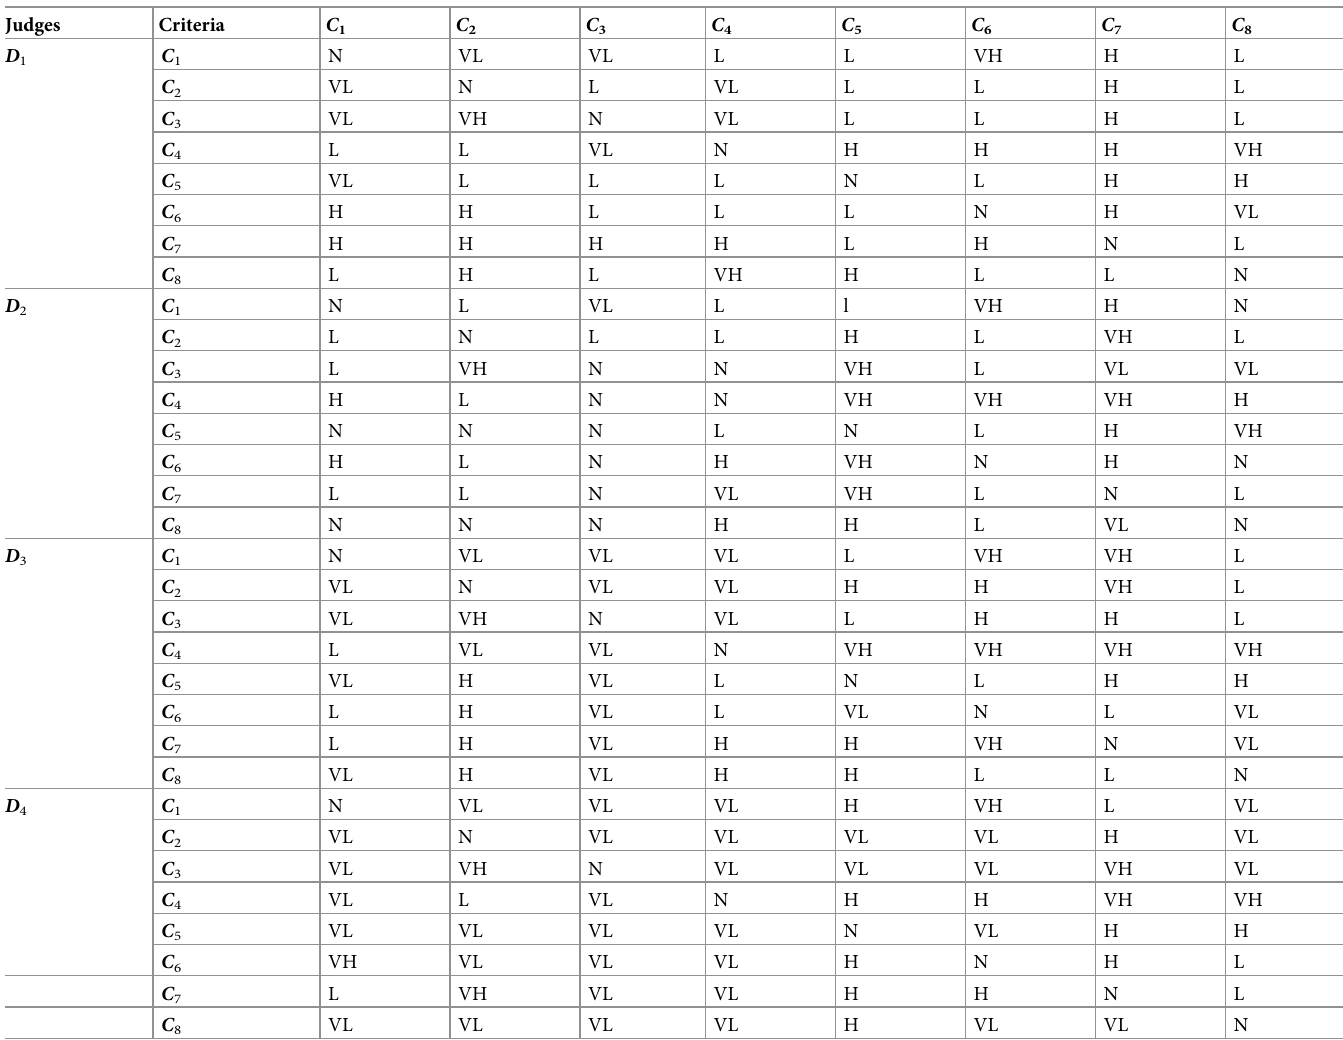
Table 5. Initial direct-influence fuzzy matrix as assessed by decision makers. Judges